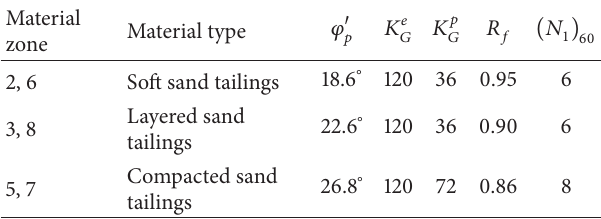
Table 2: Some input parameters of the UBCSAND